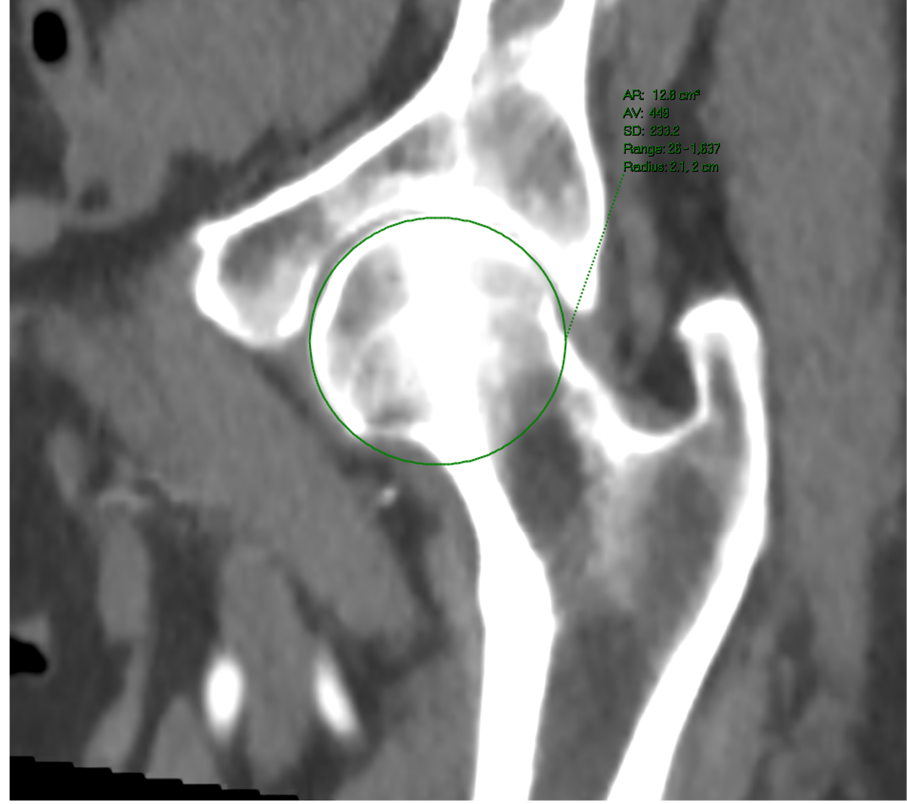
Figure 3. Femoral head perimeter measured upon MSCT.